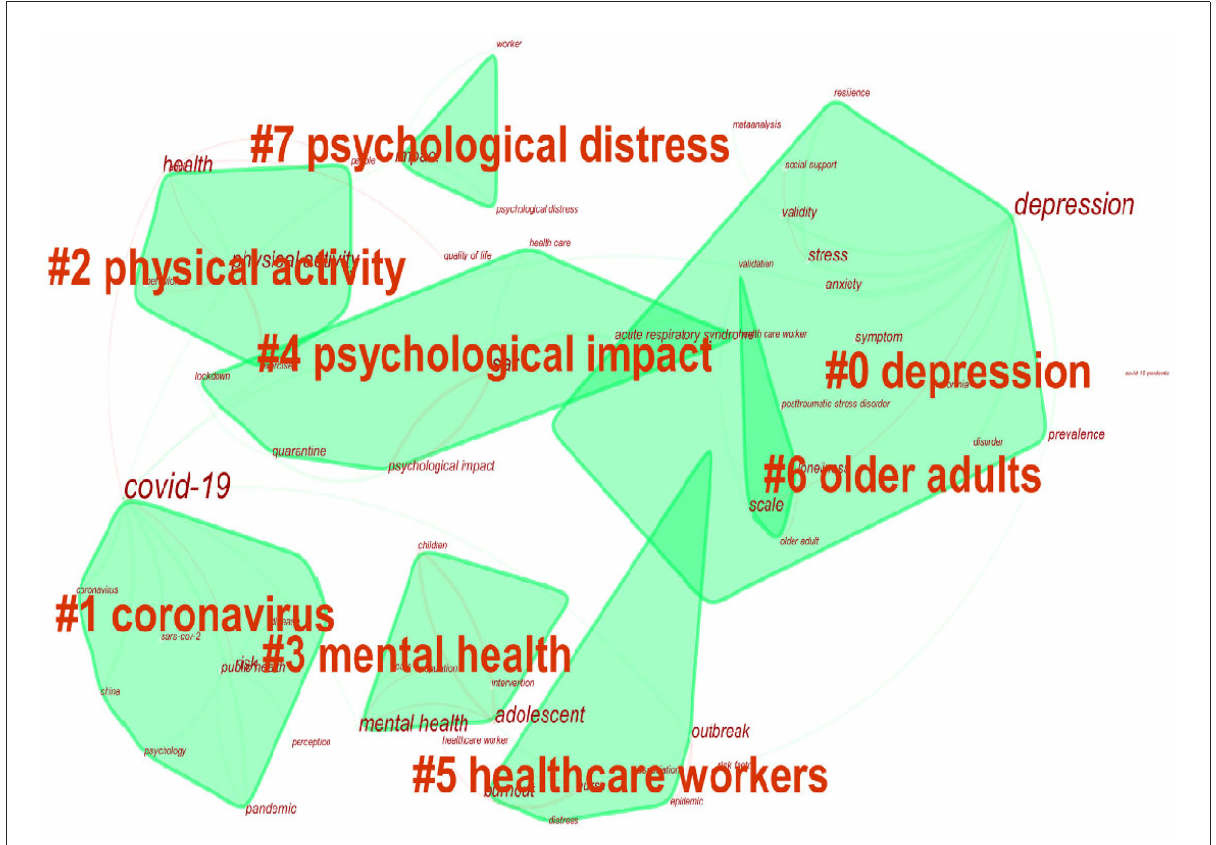
FIGURE6 The keyword cluster map for articles on mental health research related to